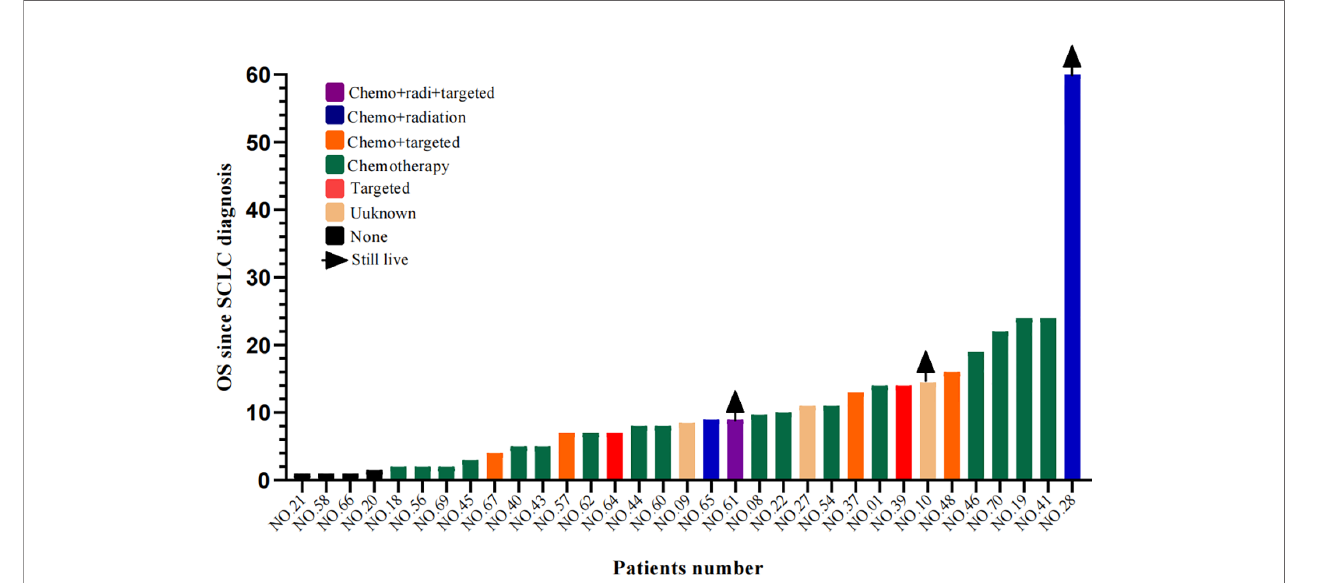
FIGURE 8 | Swimming lane diagram of OS in different therapies after SCLC transformation. OS, Overall survival.